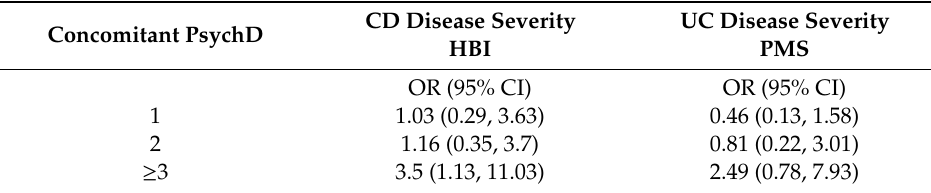
Table 5. Relationship between Crohn’s disease (CD) and ulcerative colitis (UC) disease severity and the number of concomitant current psychiatric disorders